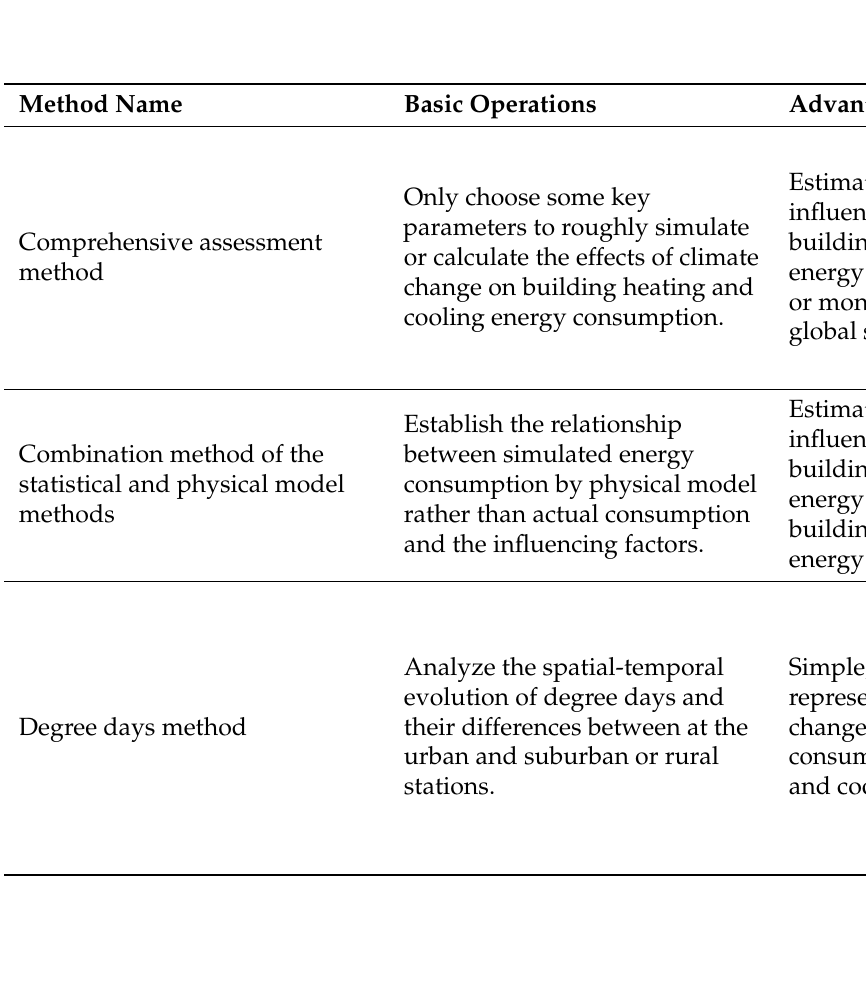
Table 1. Basic operations, advantages, and disadvantages of different methods used to estimate the impacts of climate change on the energy consumption of building heating and cooling.